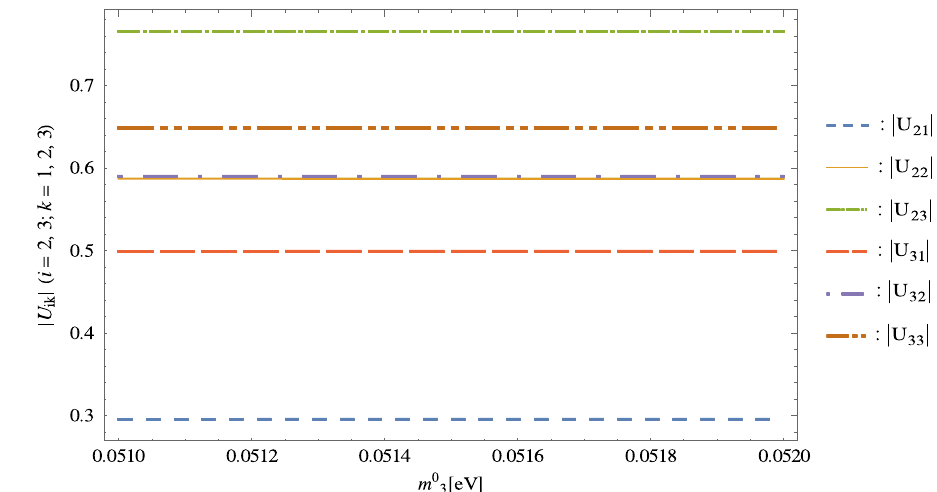
Fig. 1 | U ki | ( k = 2 , 3 ; j = 1 , 2 , 3 ) as functions of m 0 ∈ ( 0 . 051 , 0 . 052 ) eV in the m 0 3